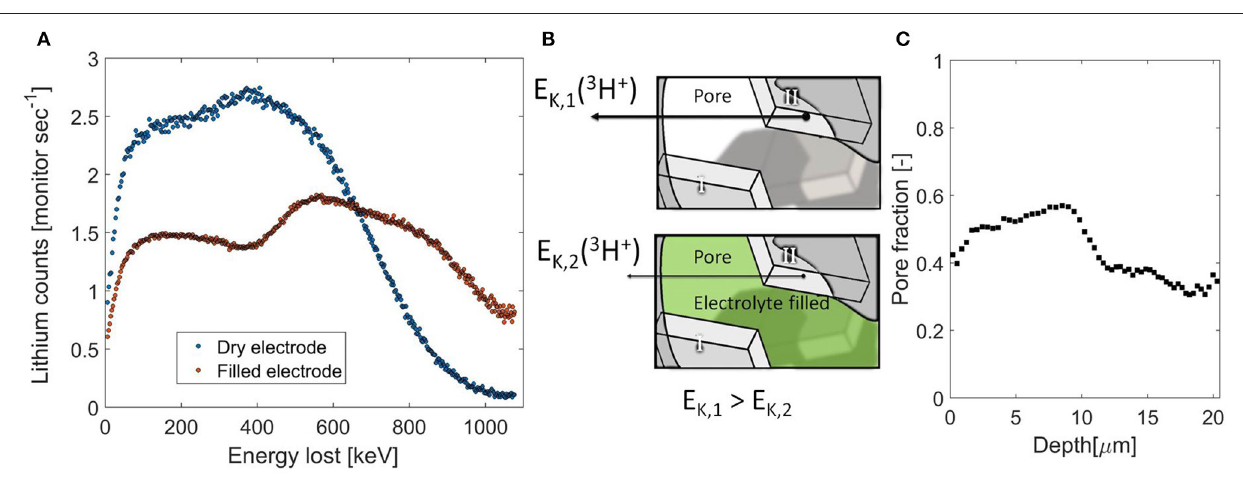
FIGURE 5 | (A) 3 H count rate vs. particle kinetic energy loss, the raw NDP data, of a double layer LiFePO 4 electrode, measured without electrolyte (blue) and measured with electrolyte (red). (B) Schematic representation of the influence of the change in stopping power due to filling of the electrode pores with electrolyte. The tetragonal shapes indicate lithium containing active material, the arrows indicate particle kinetic energy, indicating that as the electrolyte fills the pores particles from crystallite II will lose more energy than without, allow discrimination between crystallite I & II. (C) . Local porosity distribution as a function of depth. The sudden change in the middle reflects the transition into the second